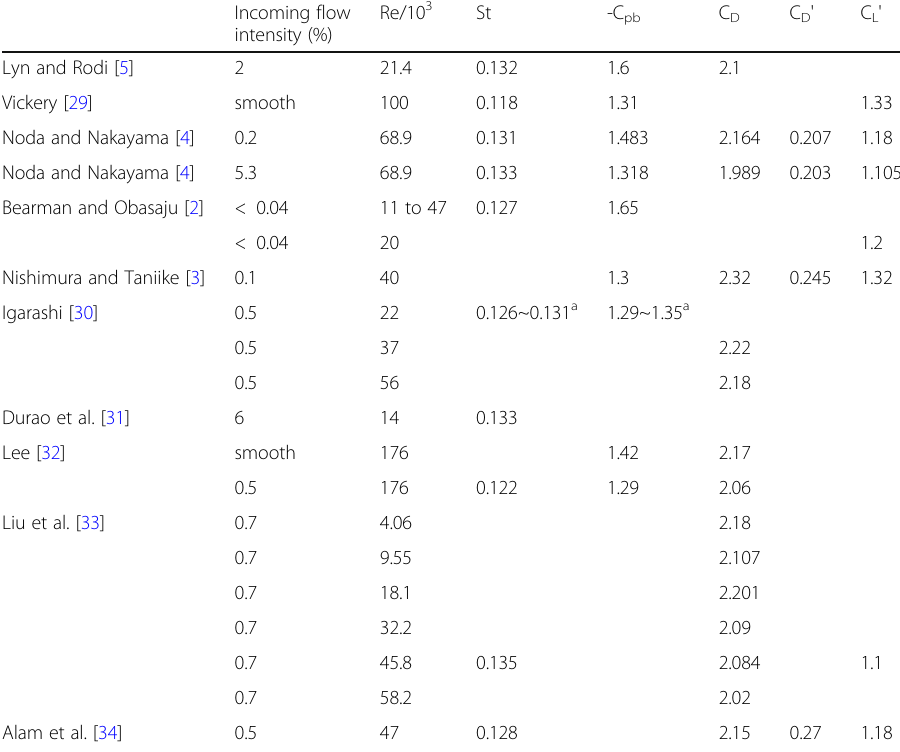
Table 1 Aerodynamic characteristics of flow over a square cylinder obtained by experiments Incoming flow Re/10 3 St -C pb C D C D ' C L intensity (%)